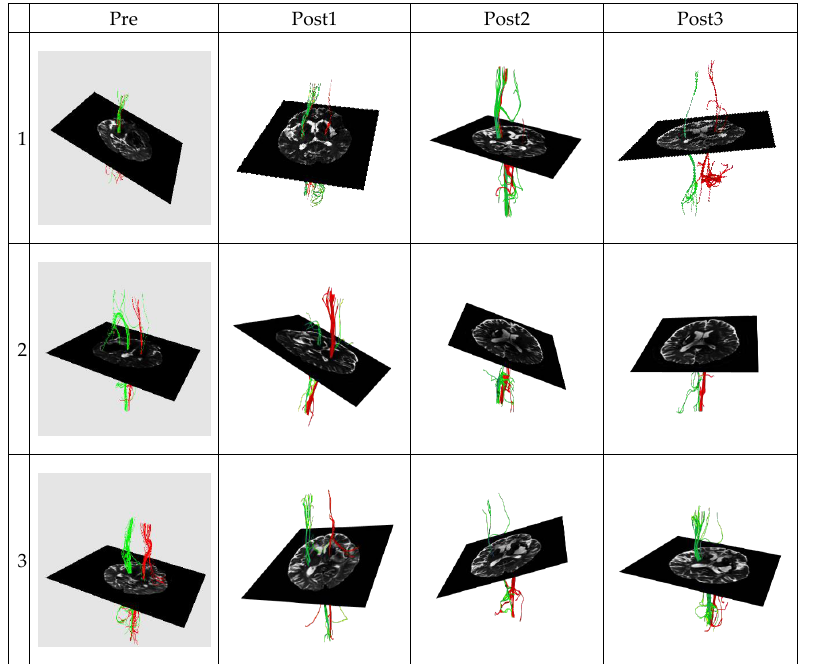
Figure 2. The corticospinal tract diffusion tensor tractography data in the poor outcome group of three patients. Green represents the corticospinal tract (CST) on the left hemisphere. Conversely, red represents the corticospinal tract (CST) on the right hemisphere.